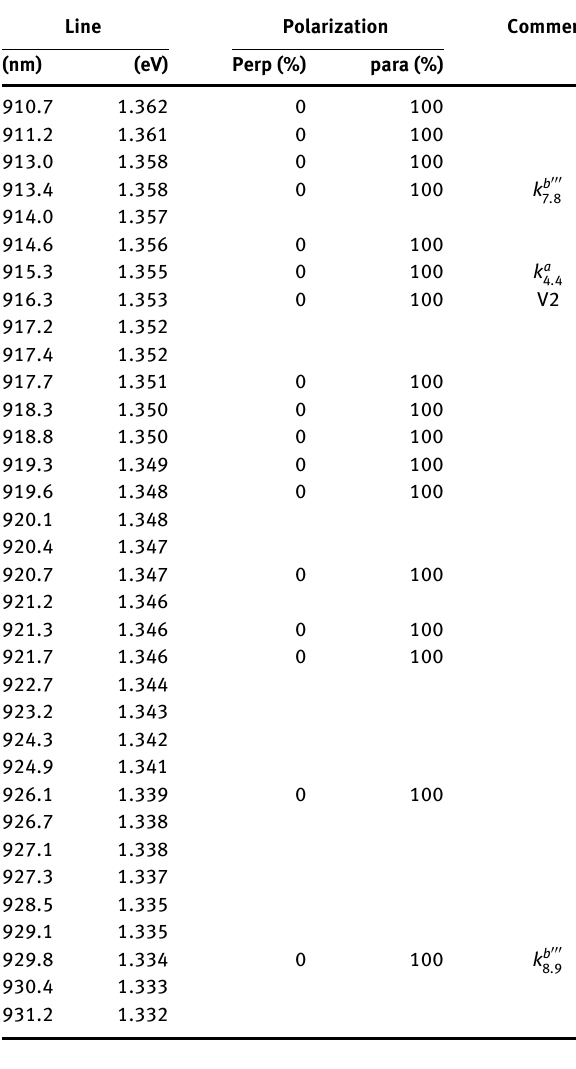
Table 4: The PL data for lines around the k isolated silicon vacancies in 4H-SiC. The polarization is normalized depending on the photon count and only shown for bright lines. Only mixed polarization with more than 5% in the minority component is shown. See Section 5.2 for more information about the assigned configurations in the comment column.